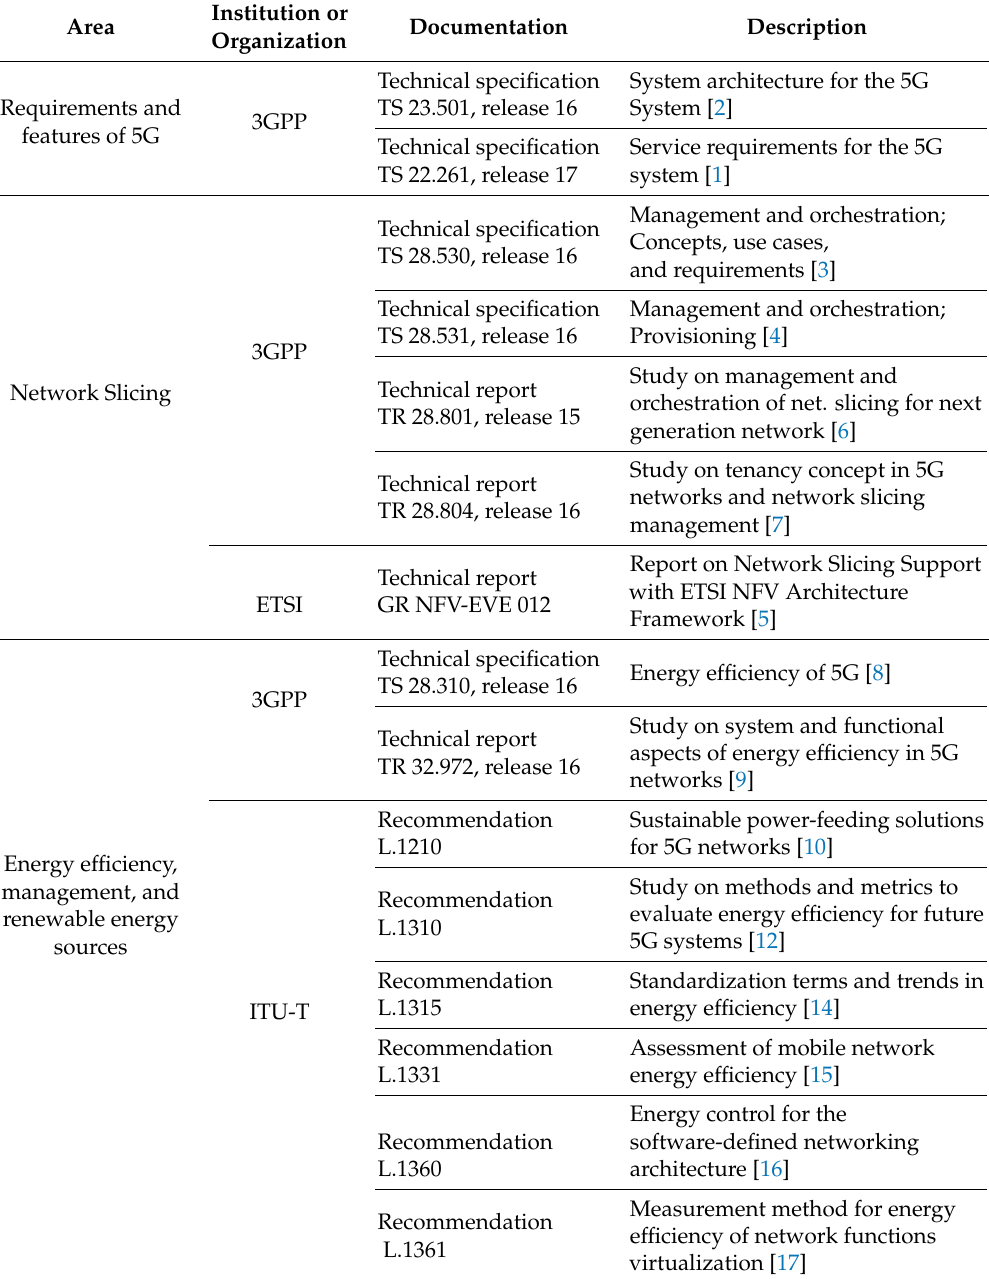
Table 3. Technical documentation related to the